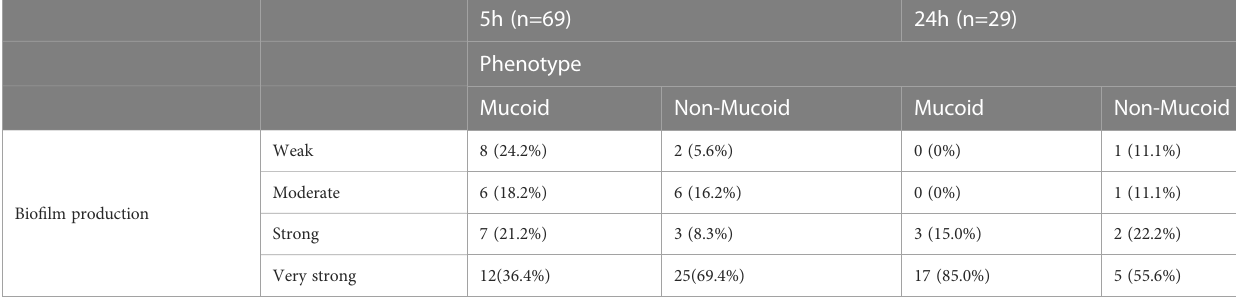
TABLE 2 Categorical strati fi cation of the BPI among mucoid and non-mucoid Pseudomonas aeruginosa strains.